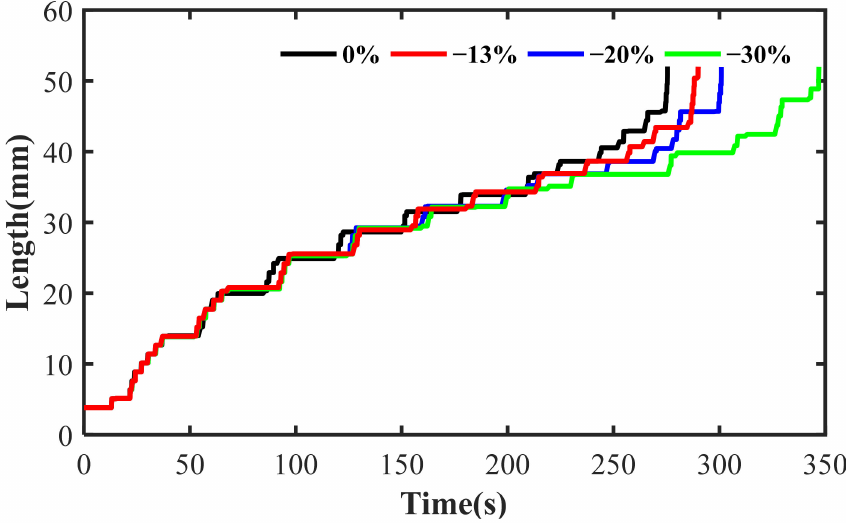
Figure 9. Fracture length changes versus time at different velocity variations.